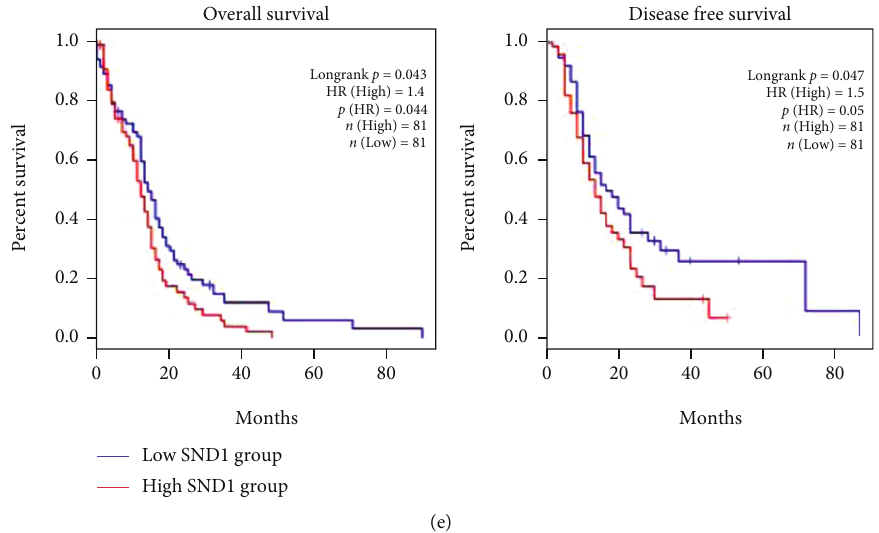
Figure 1: Expression level of SND1 gene in di ff erent cancers and pathological stages. The expression status of the human SND1 gene in di ff erent cancers tissues (a), (b) GBM, or speci fi c GBM subtypes (c) was analyzed through GEPIA 2 (http://gepia2.cancer-pku.cn/ #analysis). (d) Immunohistochemical staining of SND1 in clinical glioma tissue samples and normal brain tissues were obtained from the Human Protein Atlas (http://www.proteinatlas.org). Normal tissue, access numbers: NOS (M-00100), patient ID: 1582; glioma, malignant: low grade (M-938031), Patient ID: 3120; glioma, malignant: high grade (M-938033), patient ID: 46. (e) The e ff ect of SND1 on the overall survival and disease-free survival of glioblastoma patients was acquired from GEPIA 2.